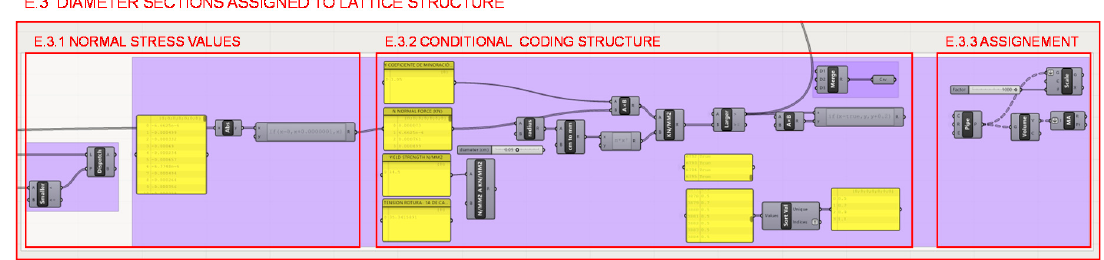
Figure 30. Programming structure for assigning the sections to the lattice structure.